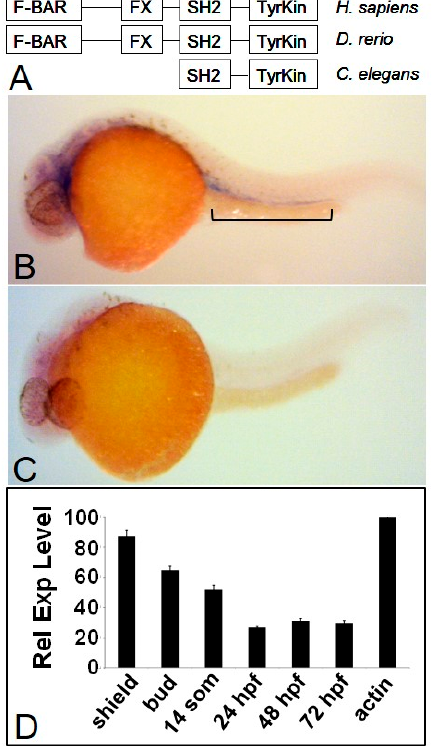
Figure 1. Fer kinase is conserved throughout evolution and is expressed during zebrafish embryogenesis. The zebrafish homologue of Fer kinase is highly conserved throughout eukaryotic organisms and contains the same domains as the human version ( A ). The zebrafish homologue of the fer kinase gene is expressed ubiquitously during early developmental stages with more specific expression emerging between 24 and 72 hpf (not shown). At 24 hpf, fer expression is observed in the intermediate cell mass (ICM) and developing brain region ( B ), when compared to a fer anti-sense probe ( C ). Quantitative PCR shows fer expression is highest during early development and tapers off by 24 hpf to three to four-fold lower levels ( D ).